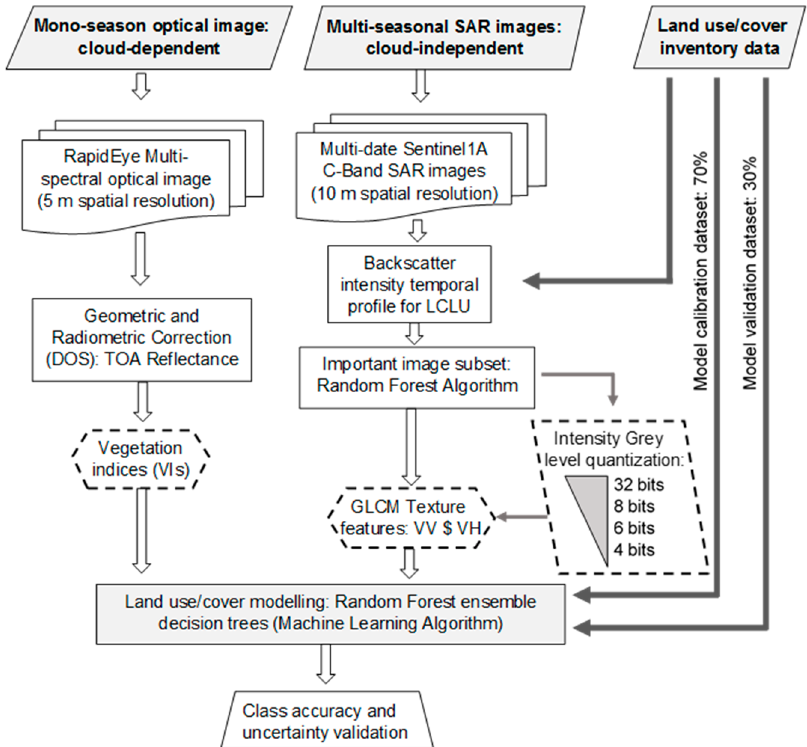
Figure 5. An outline of the image processing protocol, texture feature extraction, and land use/land cover (LCLU) delineation. The input and outputs are shaded, and broken border lines denote feature extraction. Unlike the direct use of radar backscatter intensity, and the application of the GLCM to 3-bit images, texture features were extracted after images with different grey level ranges were computed. DOS, Dark object subtraction; TOA, Top of Atmosphere.